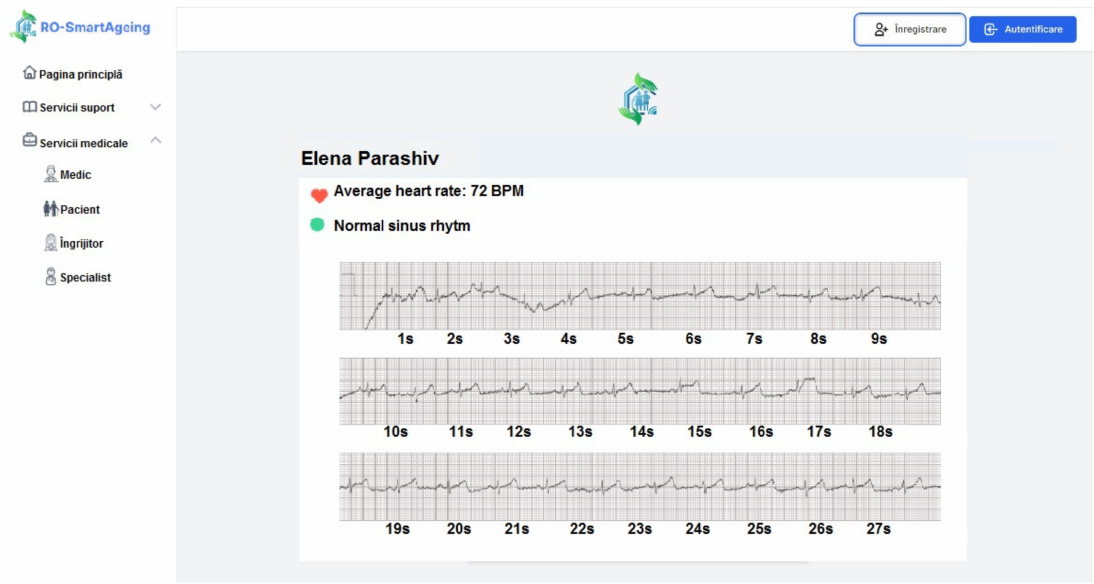
Figure 8. Measured ECG with a Withings device displayed on the RO-SmartAgeing